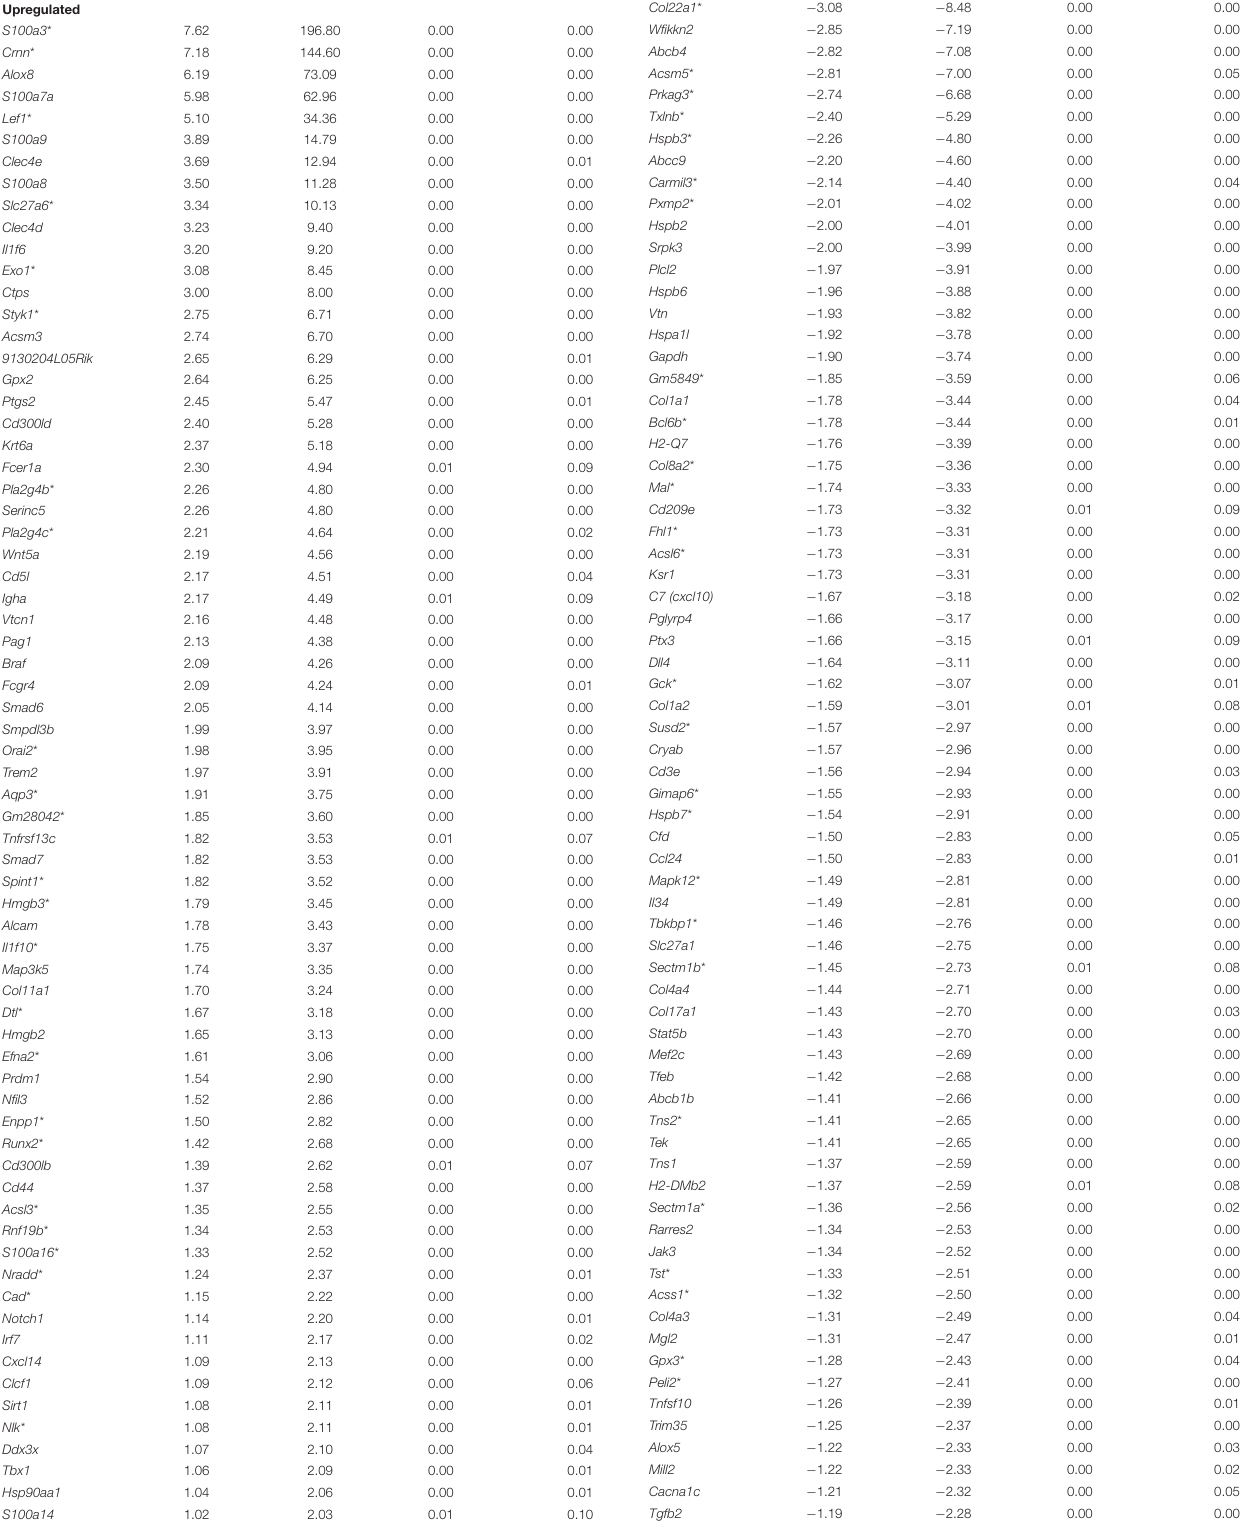
TABLE 2 | Overall immune associated transcriptional changes observed in C57BL/6 versus IL-6-deficient (KO) normal